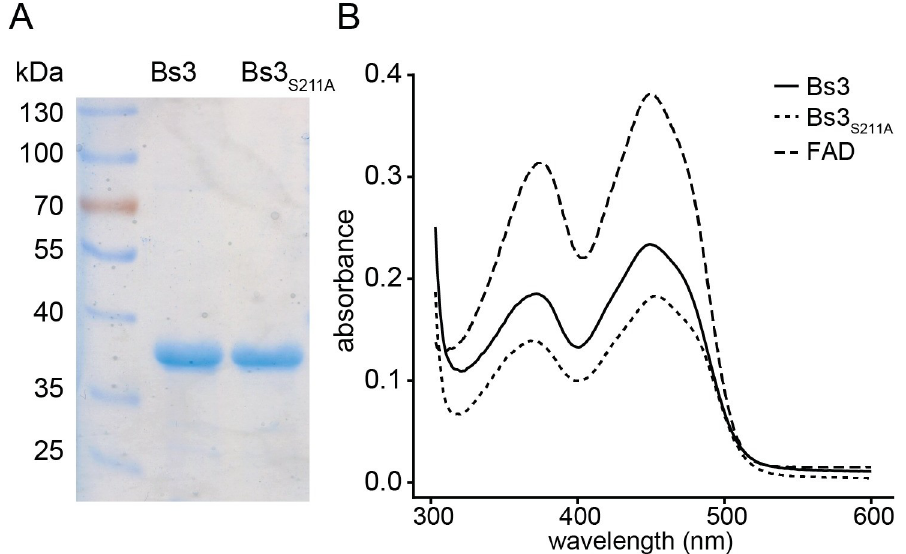
Fig 3. Recombinantly expressed Bs3 and Bs3 S211A bind the cofactor FAD. A) Recombinant Bs3 and Bs3 S211A proteins were expressed in E . coli , affinity purified and loaded onto an SDS polyacrylamide gel. B) UV-vis spectrum of FAD (dashed line), Bs3 (solid line) and Bs3 S211A (dotted line).